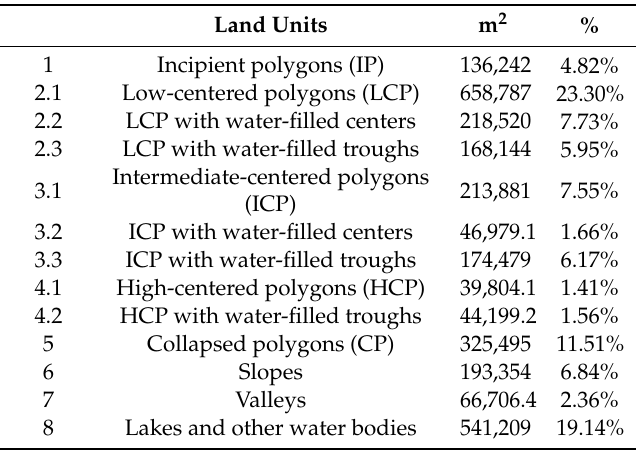
Figure 9. A geomorphology map that is the result of the described mapping procedure and shows the spatial distribution of all mapped land units. Legend: 1 – incipient polygons (IP); 2.1 – low-centered polygons (LCP); 2.2 – LCP with water-filled centers; 2.3 – LCP with water-filled troughs; 3.1 – intermediate-centered polygons (ICP); 3.2 – ICP with water-filled centers; 3.3 – ICP with water-filled troughs; 4.1 – high-centered polygons (HCP); 4.2 – HCP with water-filled troughs; 5 – collapsed polygons (CP); 6 – slopes; 7 – valleys; 8 – lakes and other water bodies; 9 – the Samoylov Island research station. Table 1. The distribution area of each land units (without the Samoylov Island research station) and their